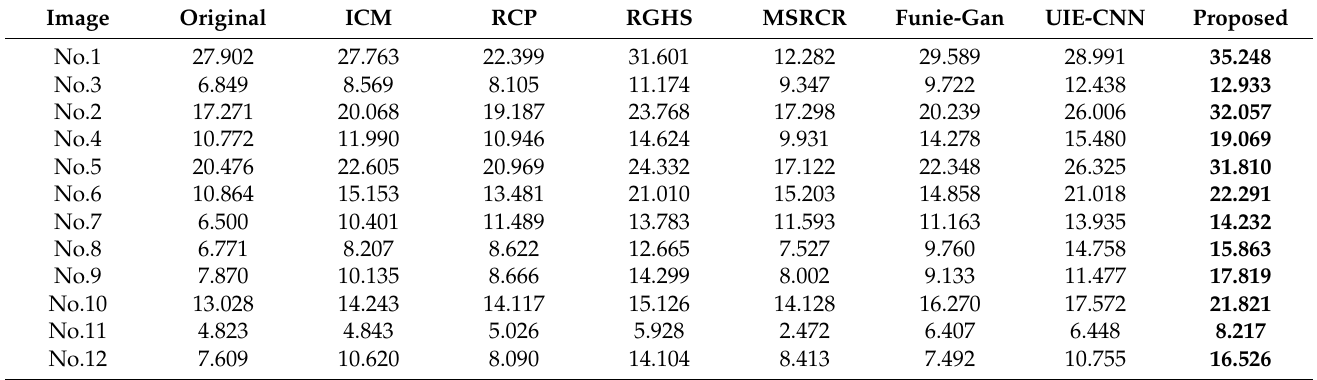
Table 5. Evaluation of processed images by the metric RMS